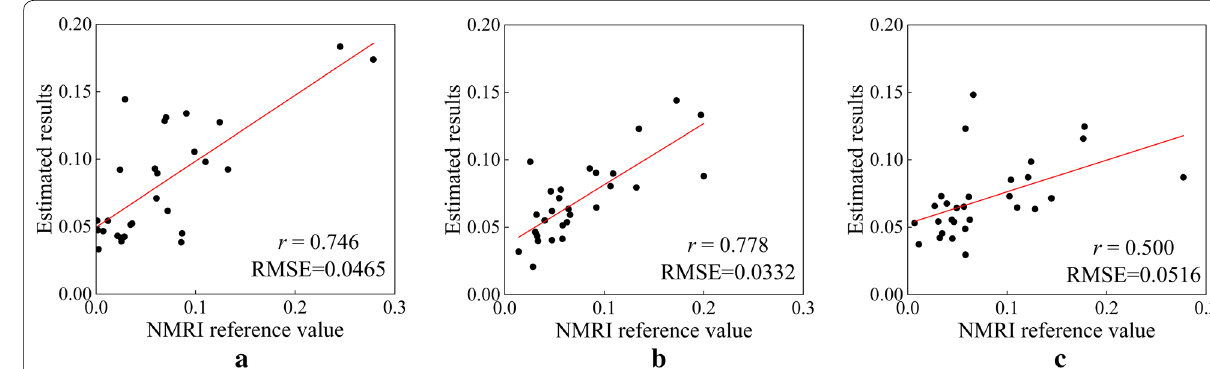
Fig. 7 Comparison of K -fold cross-validation of three models: a BP; b GA–BP; c MLR